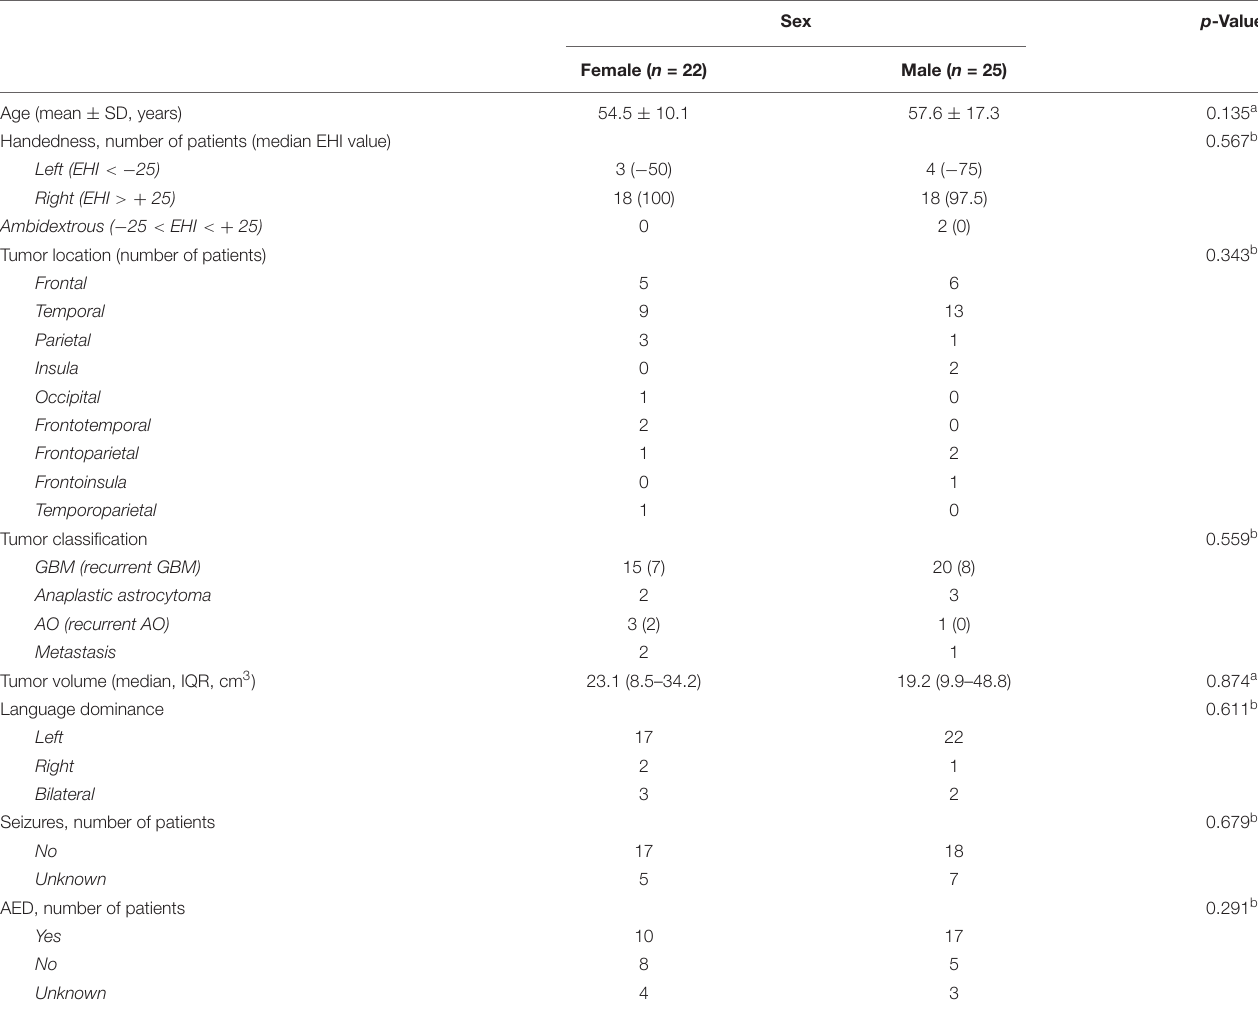
TABLE 1 | Demographic and clinical characteristics of the